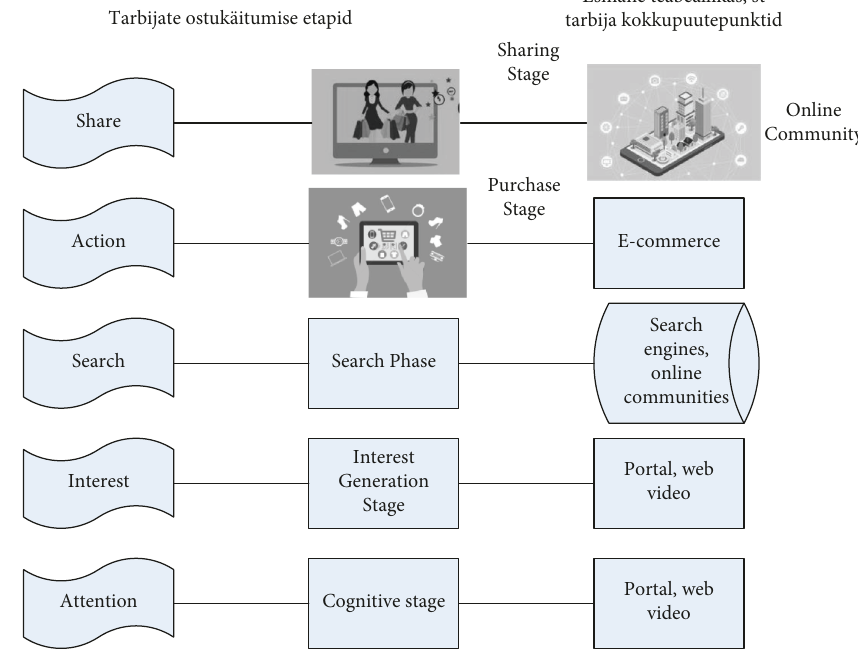
Figure 1: Consumers have online touchpoints at different stages of